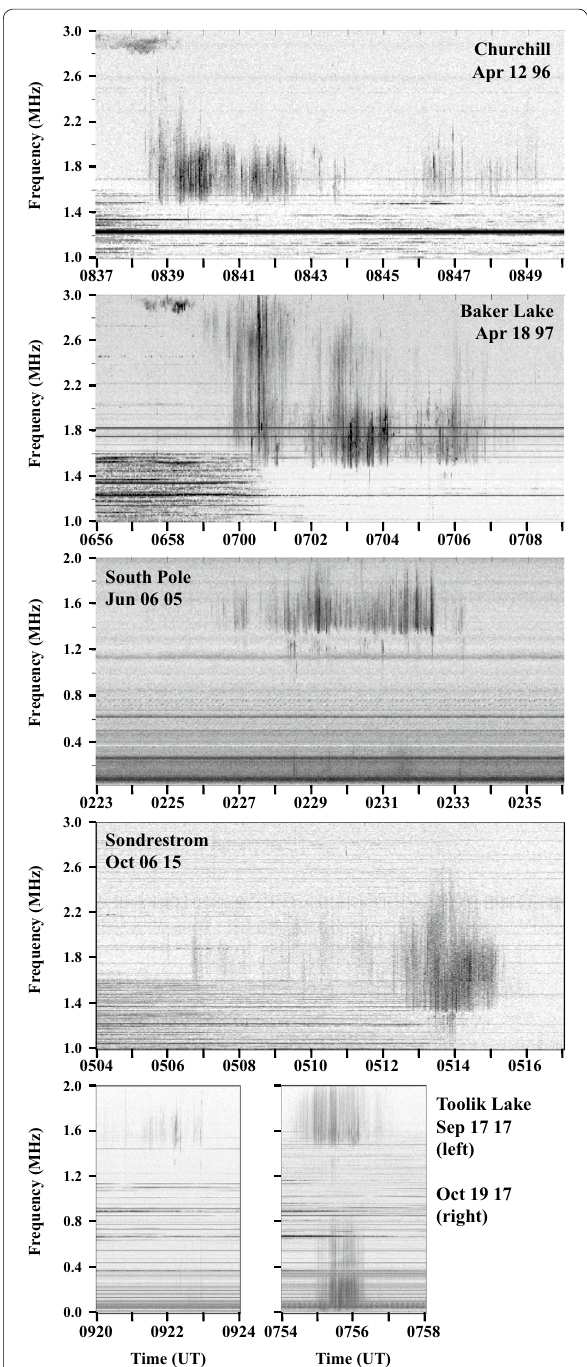
Fig. 1 Spectrograms showing six examples of MFB emissions observed at five sites. The events are all of an unusual type, in which the MFB has a distinct lower cutoff at 1.3–1.5 MHz, with a gap below, and sporadic emissions extending from below the gap to as low as 1.0 MHz. In some cases, auroral hiss is observed below 1.0